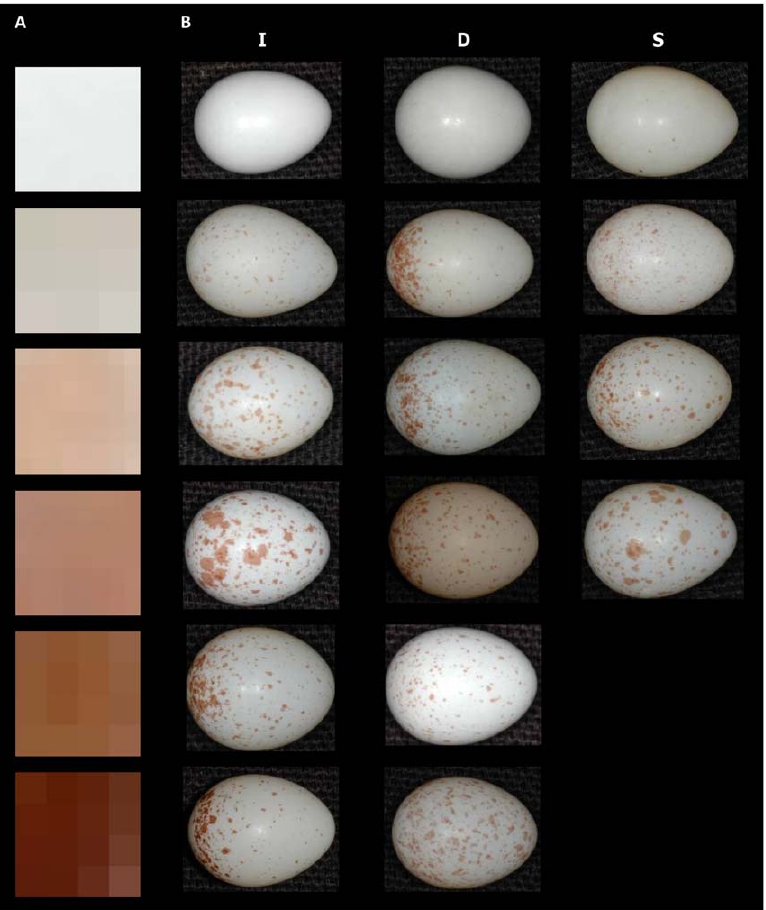
Figure 1. Between-female variation of eggshell spottiness in the studied blue tit population in southern France. (A) Intensity code, (B) standard of comparison. Intensity I: 0, no spot, 1, feint, 2, pale, 3, medium, 4, some intense spots, 5, intense. Distribution D (approximate percentage spotting in one-half, typically the blunt end): 0, no spot, 1, . 81%, 2, 71–80%, 3, 61–70%, 4, 51–60%, 5, 50%. Spot size S: 0, no spot, 1, small, 2, medium, 3, large. Rows represent increasing values from top to bottom. After [26,28]. Egg pictures by